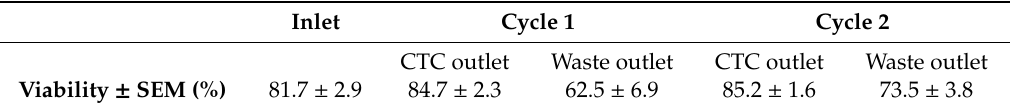
Table 3. Viability of cells collected from CTC and waste outlets after Cycle 1 and Cycle 2 of the process. Data represent the average of three experiments ± Standard error of the mean (SEM).